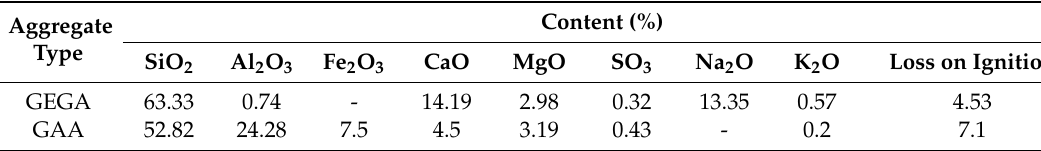
Figure 1. Structure of the aggregates used in the research: ( a ) granulated expanded glass aggregate Table 2. Chemical composition of the aggregates.